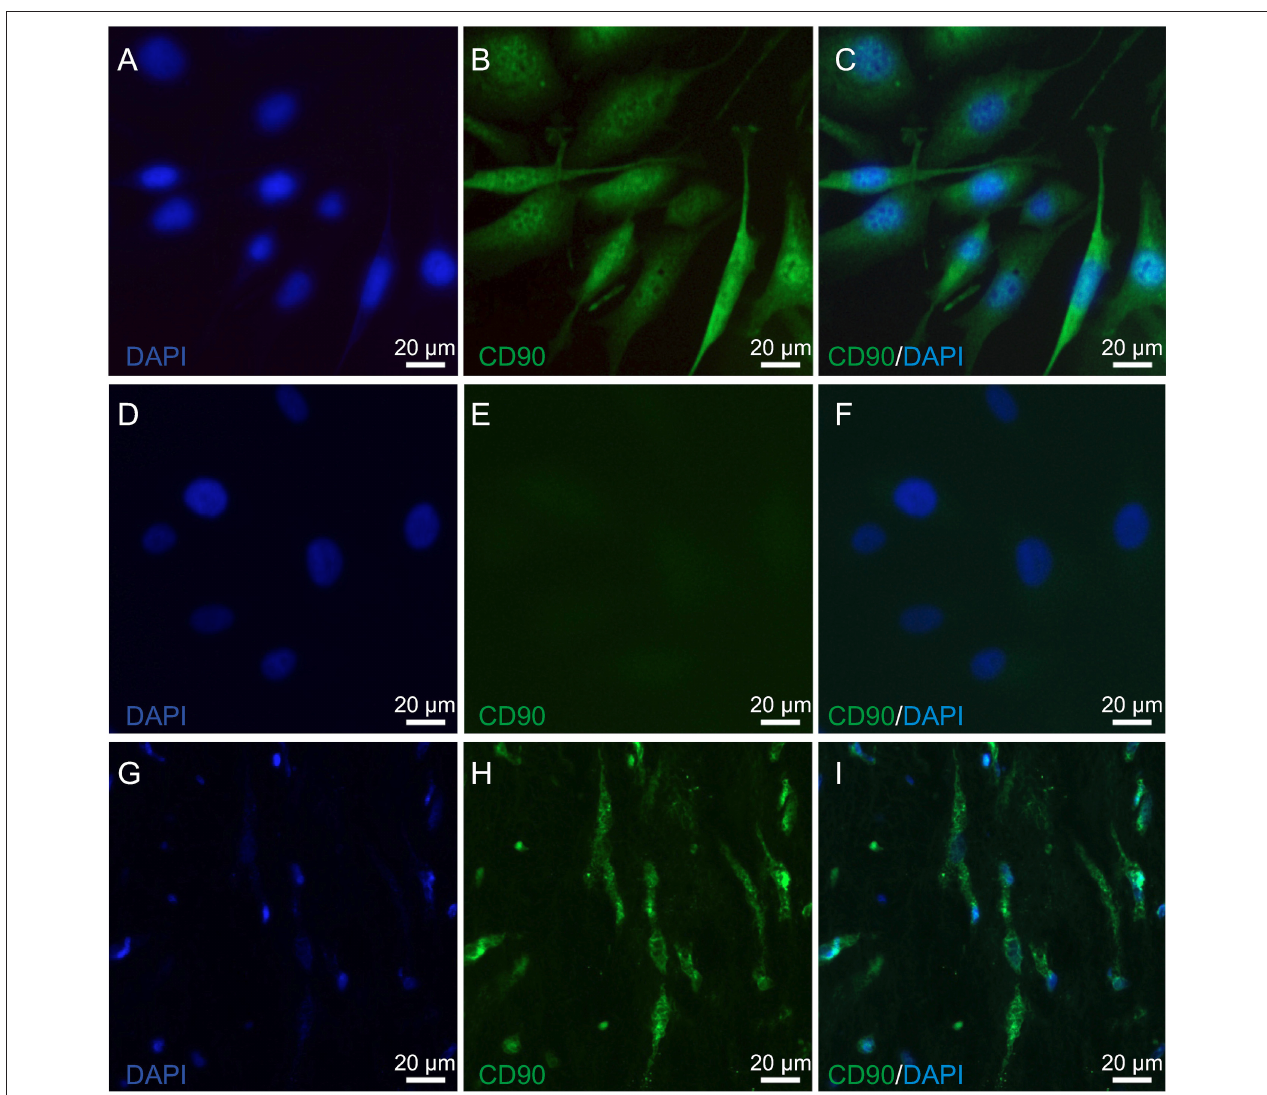
FIGURE 2 | Mesenchymal stem cell identification in HCK and pIHC. (A) Nuclear staining of HCK with DAPI (blue). (B) Anti CD90 IF antibody green staining detected in HCK. (C) Merged B image with DAPI blue staining of cell nuclei. (D) DAPI blue staining of nuclei in HCK. (E) Omission of anti-CD90 antibody green staining pattern validates primary antibody in HCK. (F) Similar as E but with DAPI (blue) (merged). (G) Nuclear staining of human corneal stroma (pIHC) with DAPI (blue). (H) IF analyses of anti-CD90 antibody green staining in pIHC as a positive control. (I) Merged image shown in H panel with DAPI blue